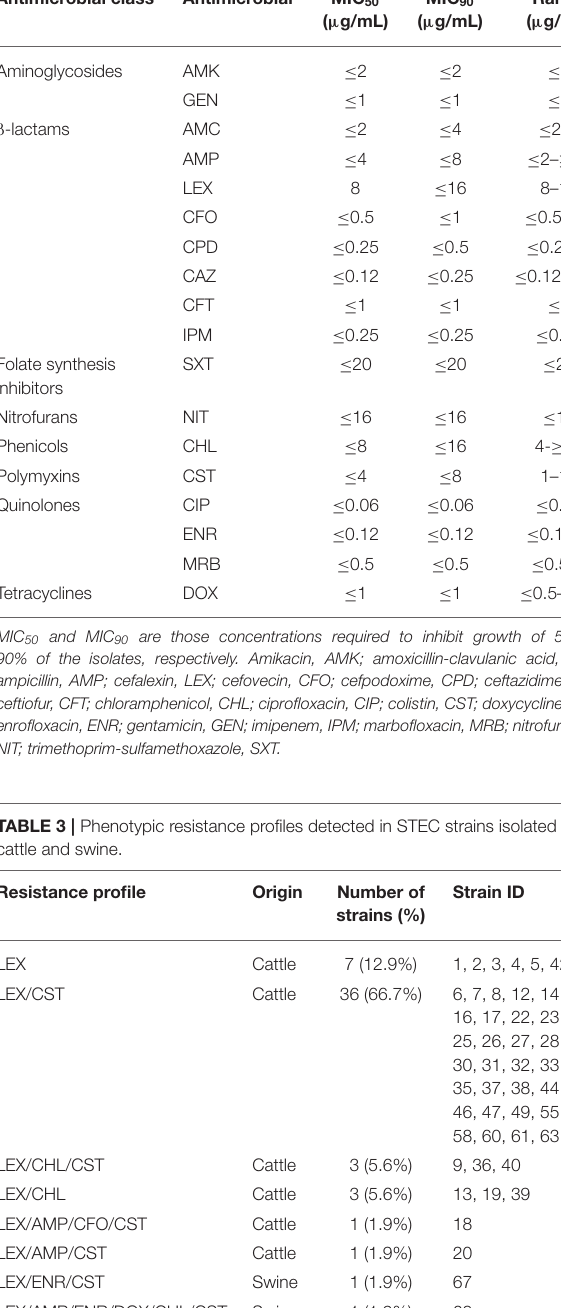
TABLE 2 | MICs of selected antimicrobials against STEC strains isolated from cattle and swine. Antimicrobial class